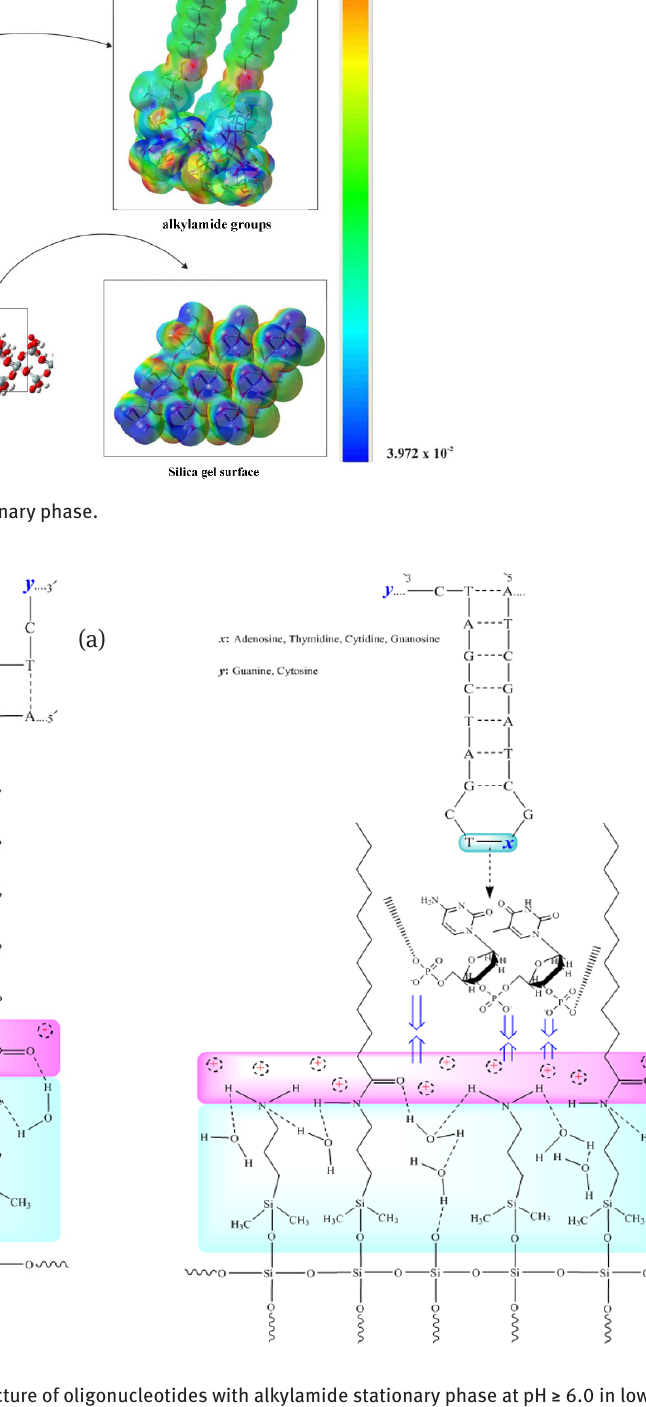
Figure 2: (a) Interaction schemes of secondary structure of oligonucleotides with alkylamide stationary phase at pH ≥ 6.0 in low salt concentration. (b) Interaction schemes of secondary structure of oligonucleotides with alkylamide stationary phase at pH ≤ 5.0 in low salt